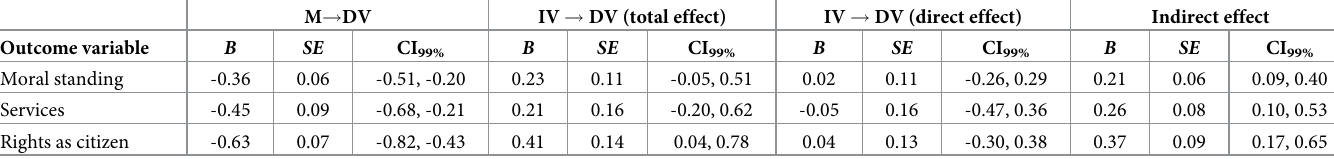
Table 7. Mediation model statistics: Effects of recovered agency on rights via dangerousness (Study